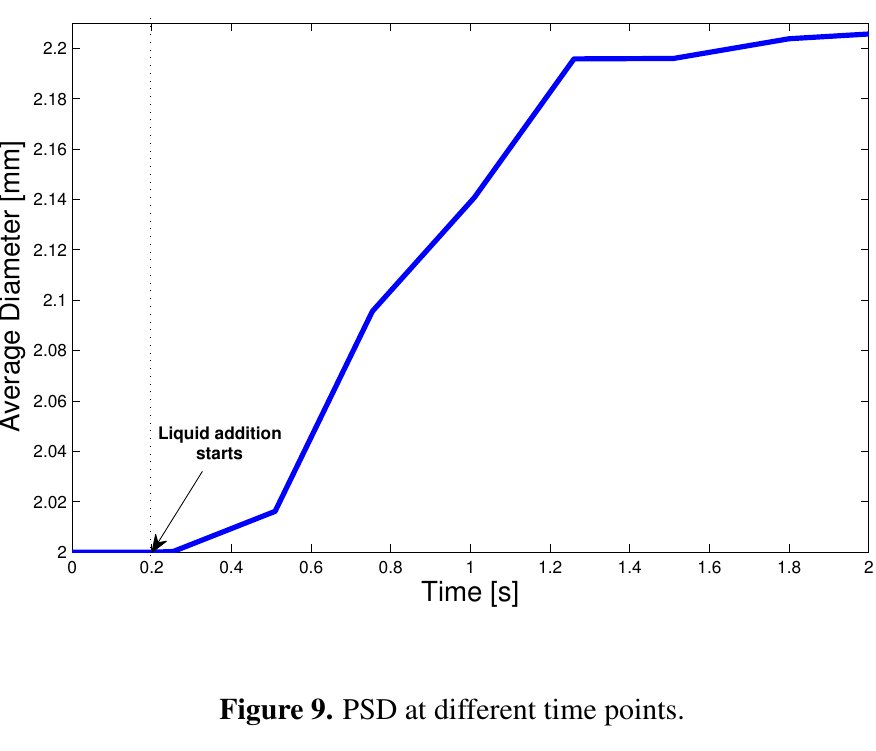
Figure 9. PSD at different time